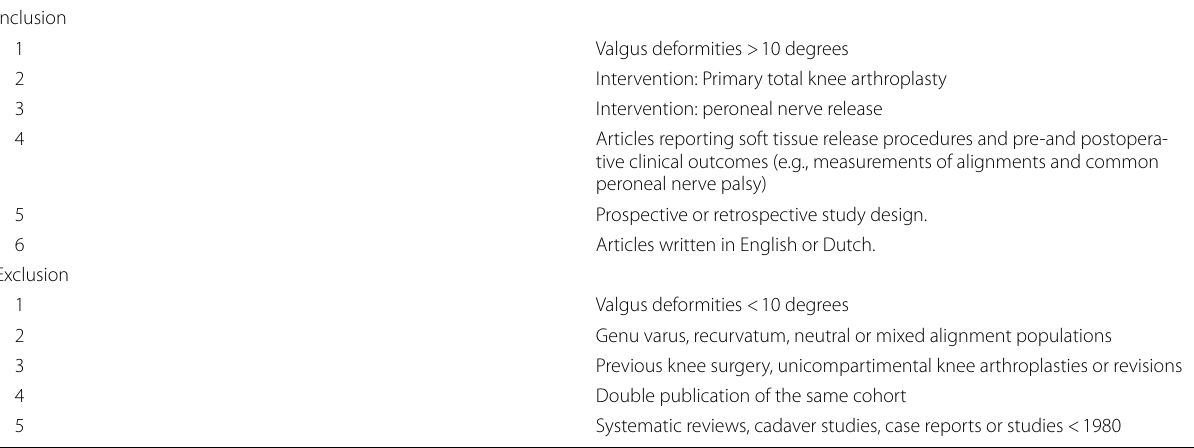
Table 2 Inclusion and exclusion